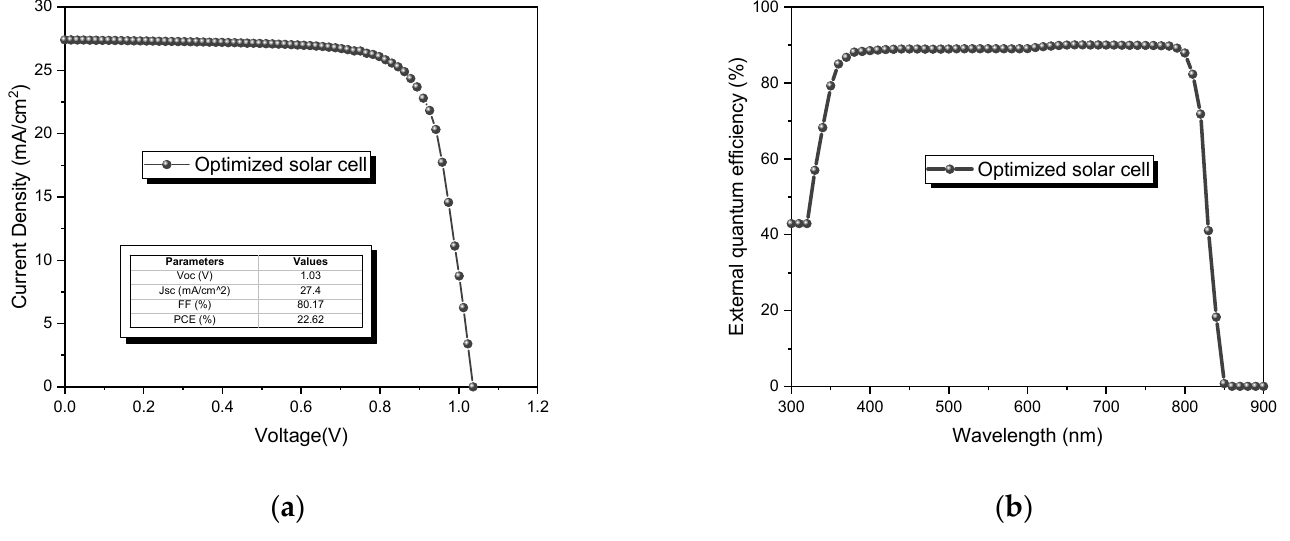
Figure 12. Optimized CdTe solar cell: ( a ) J-V curve and ( b ) external quantum efficiency.